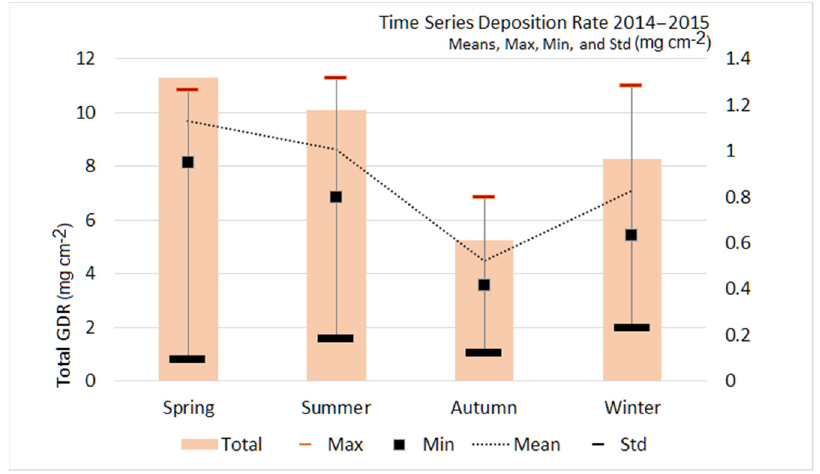
Figure 6. Seasonal average deposition rate gathered from the GDR.